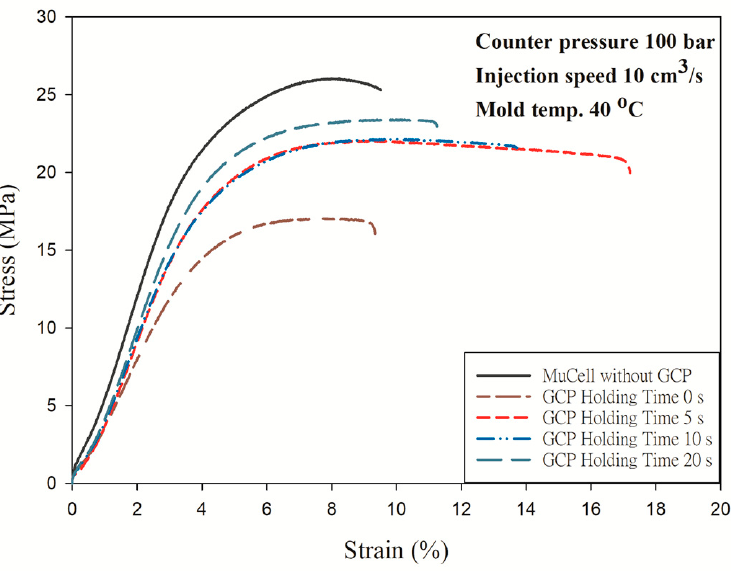
Figure 13. Stress–strain curves of microcellular injection-molded PP with GCP of 100 bar and different holding times.